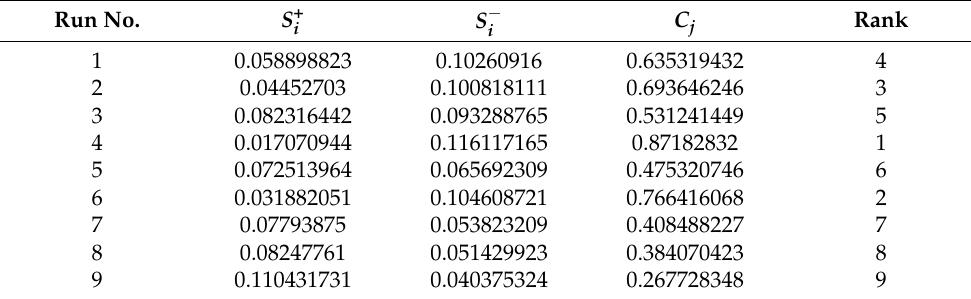
Table 11. Standardized and weighted decision matrices for performance indicators. Run